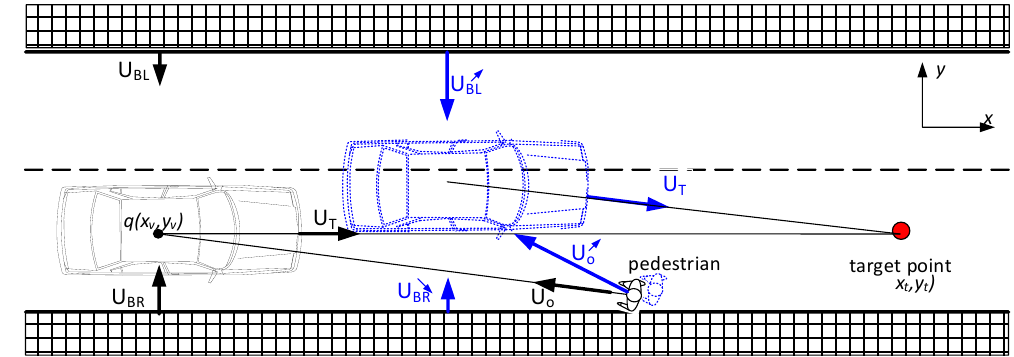
Figure 3. Scheme of changes in interactions .